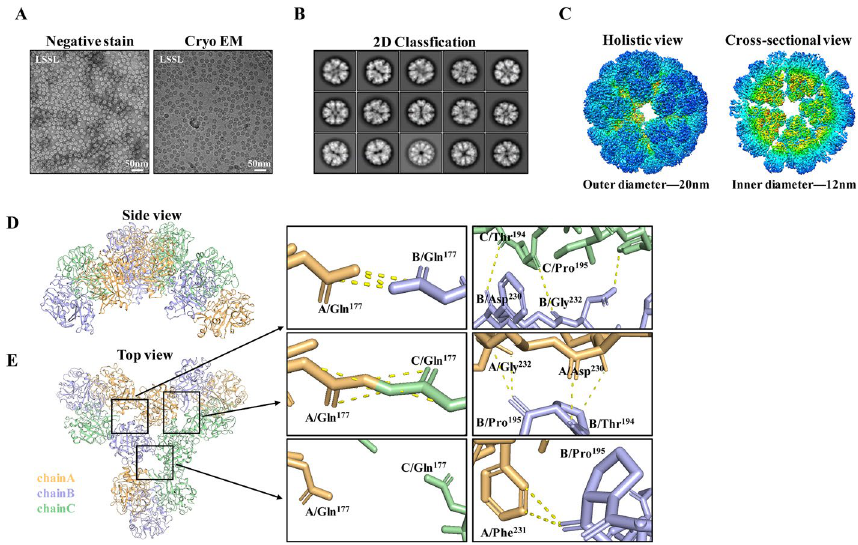
Fig. 2 Structure and interactions of LSSL. A A representative negative stain (left) and cryo-electron microscopy (EM) (right) raw micrograph of LSSL. B Two-dimensional class averages of LSSL. C Surface representation of LSSL, viewed down the five-fold axis and colored by the radius (left). Cross-sectional view showing the internal features. LSSL assembled as icosahedral capsids, composed of incomplete symmetrical structure of five tetramers. Side view ( D ) and top view ( E ) of a tetramer structure. The interactions between tetramers in three orientations are shown in E . Orange, violet, and green indicate chain A, chain B, and chain C, respectively. The boxes indicate the magnified views of the interactions, and the representative residues are shown